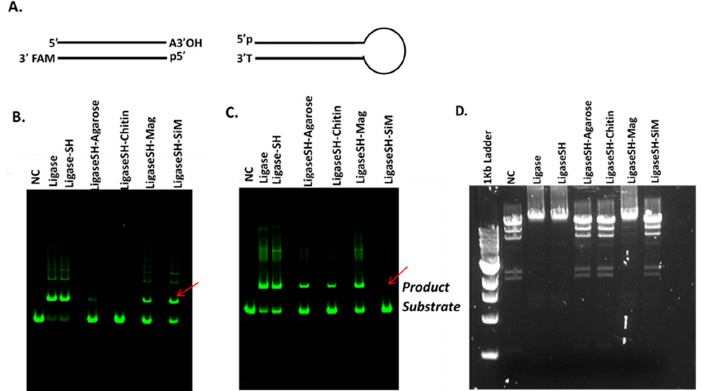
Figure 2. Comparison of enzymatic activity of soluble T4 DNA ligase versus the soluble SNAP-tagged T4 DNA ligase (Ligase SH) and various beads immobilized versions. Ligation activity was assayed by joining two synthetic DNA duplexes with a single A/T base pair overlap ( A ) in the presence of 1× Blunt/TA ligation buffer at 23 °C for 15 min ( B ) or 1× T4 DNA ligase reaction buffer at 23 °C for 2 h ( C ) and visualized by fluorescent scanning following polyacrylamide gel electrophoresis. The arrows indicate the presence or absence of the ligation product in the Ligase-SiM reactions. Ligation of HindIII-digested Lambda DNA fragments was carried out in 1× T4 DNA ligase reaction buffer at 23 °C for 2 h and examined by agarose gel electrophoretic separation ( D ).